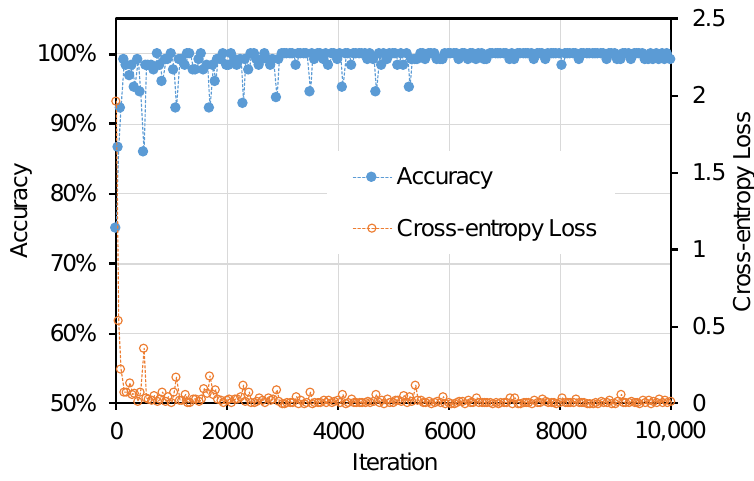
Figure 6. Accuracy and cross-entropy loss of the bolt detector during the training process.